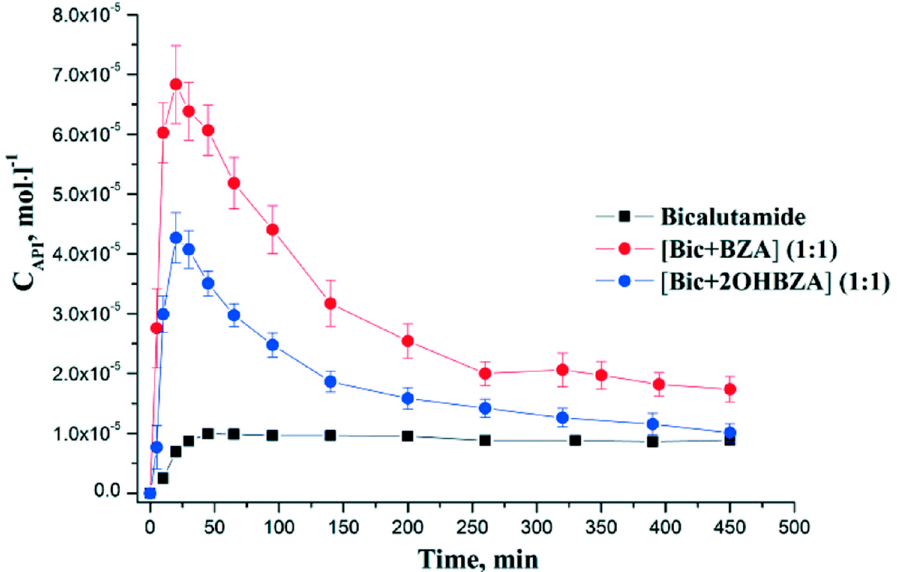
Figure 10. Dissolution profiles for the cocrystals (Bic + BZA and Bic + 2OHBZA) and pure bicalutamide in the pH 7.4 phosphate buffer at 25 °C. Adapted with permission from CrystEngComm, 2016, 18 , 4818–4829. Copyright 2016, The Royal Society of Chemistry.